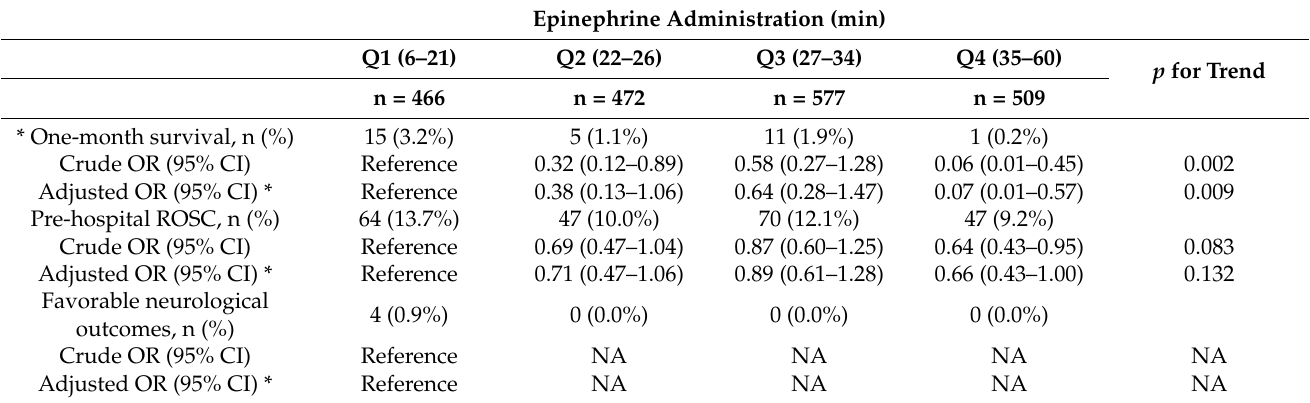
Table 2. The comparison of the primary and secondary outcomes of epinephrine